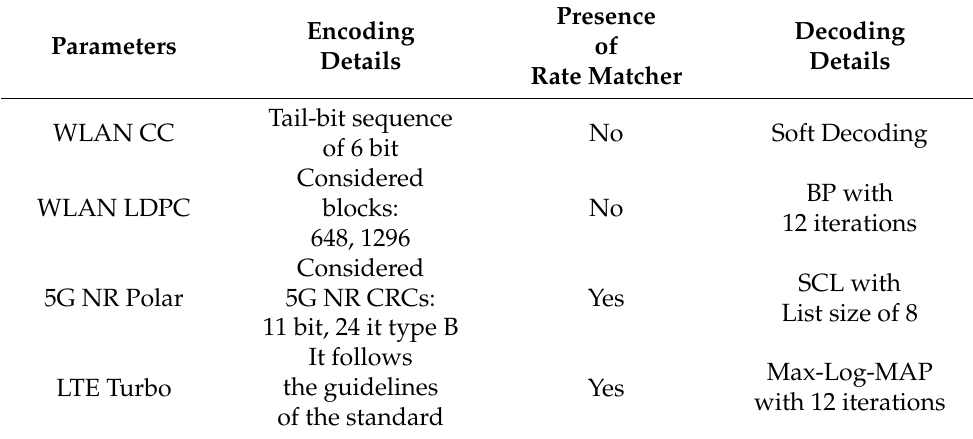
Table 3. Channel coding